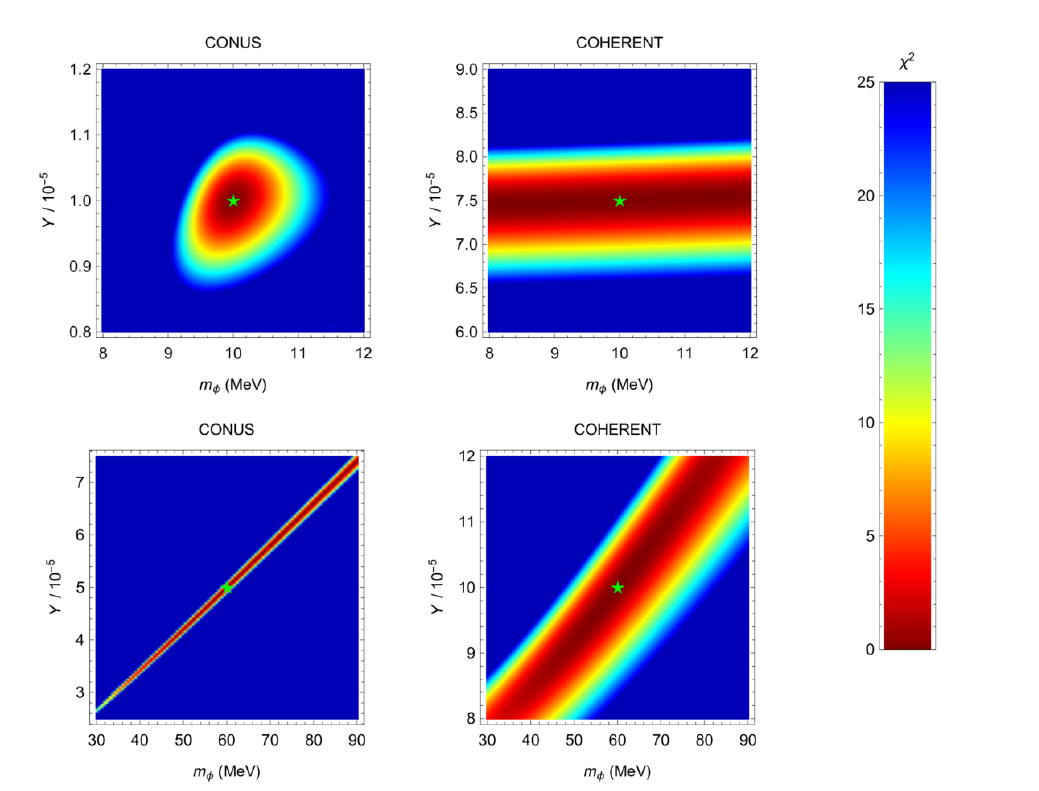
Figure 6 . Measurements of the mass m (cid:30) and coupling Y in CONUS100 (left panels) and CO- HERENT (stat. 100) (right panels) assuming the presence of a scalar boson, with the true values (cid:2) indicated by the green